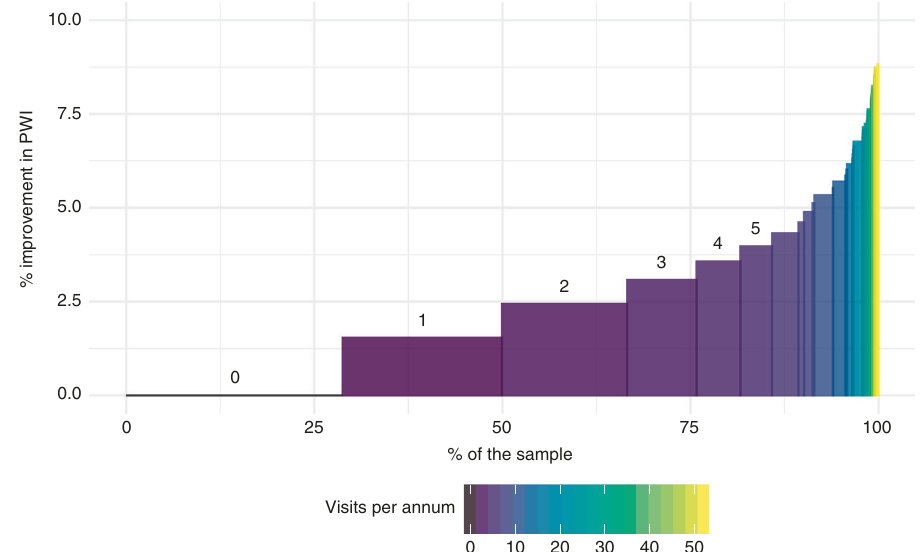
Fig. 2 Distribution of quality-of-life improvement derived from protected area visitation. Distribution of quality-of-life (QOL) improvement derived from protected area visitation across the sample population, pilot trial 2. Vertical axis shows QOL improvement, measured as % increase in self-perceived personal wellbeing index, PWI, controlled for socioeconomic and demographic factors and non-park greenspace use. Horizontal axis shows proportions of sample population. Colours show the number of visits to protected areas during the preceding 12 months. For low annual visit frequencies, 0 – 5 inclusive, frequencies are also indicated by numerals above the bars. Thirty per cent of the sample had not visited parks at all during the past year, and hence experienced no improvement in PWI. The majority of the sample population, shown in purple, had visited a protected area 1 – 5 times in the preceding year, yielding small but signi fi cant improvements in self-perceived wellbeing. Much smaller proportions of the sample population, shown in blue, green, and yellow, had visited monthly, weekly or daily, with improvements in PWI up to ~8%